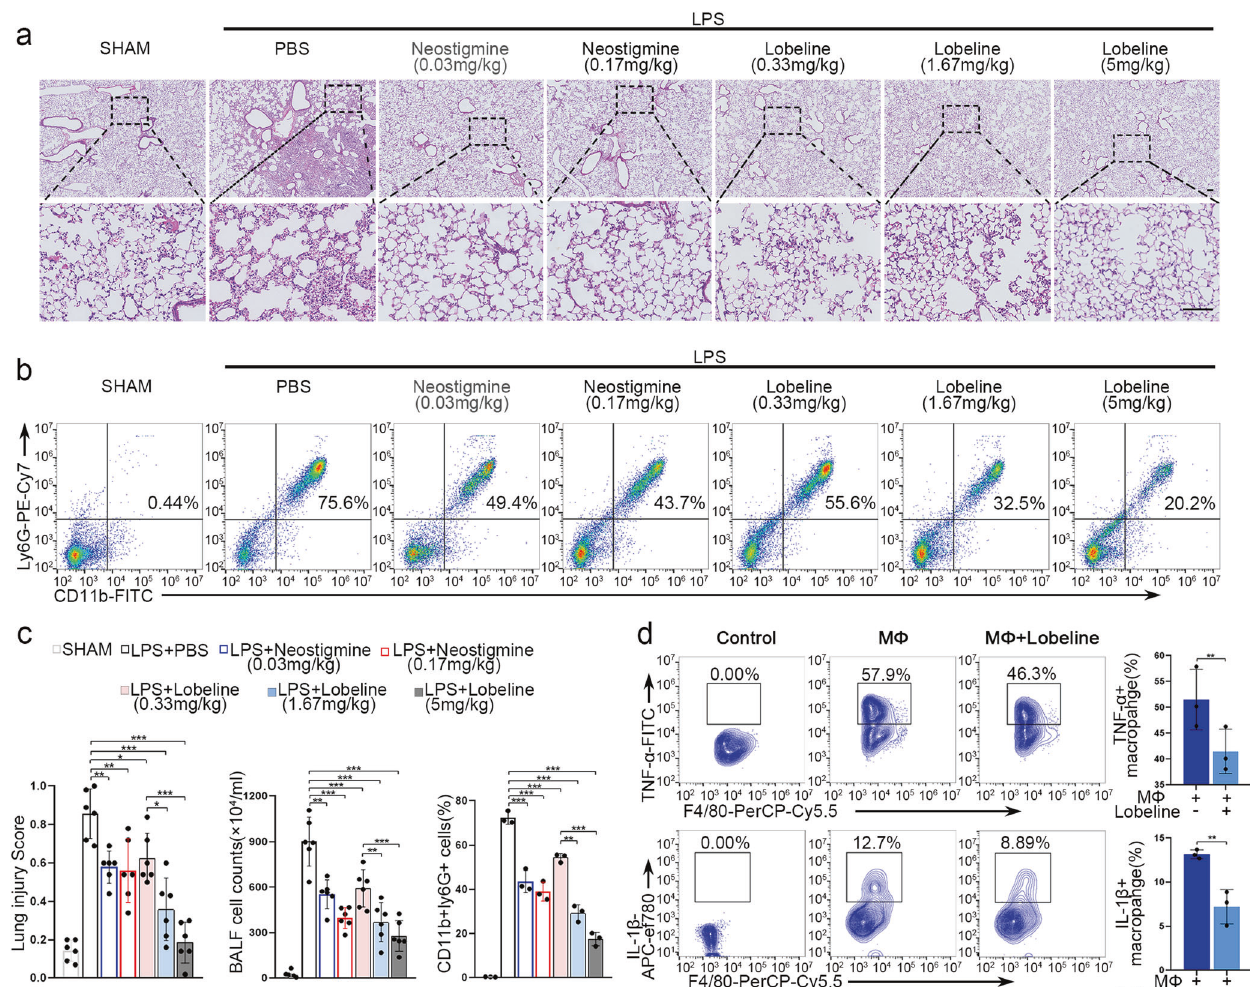
Fig. 5 The potential anti-in fl ammatory properties of lobeline in the treatment of lung injury. a Representative H&E staining was performed on lung samples from each group. Photographs of at least 6 sections of each tissue sample were taken. Scale bars, 100 μ m. b The numbers of BALF-in fi ltrating neutrophils in each group were analyzed by fl ow cytometric analysis. c The degree of lung injury was calculated and quantitatively analyzed according to the results of H&E staining, and the in fi ltration of leukocytes into BALF was compared among the groups; n = 6. Quanti fi cation of the percentage of neutrophils in BALF is shown; n = 3. d Representative plots of the percentage of TNF- α + and IL- 1 β + macrophages and quanti fi cation of the results were presented; n =